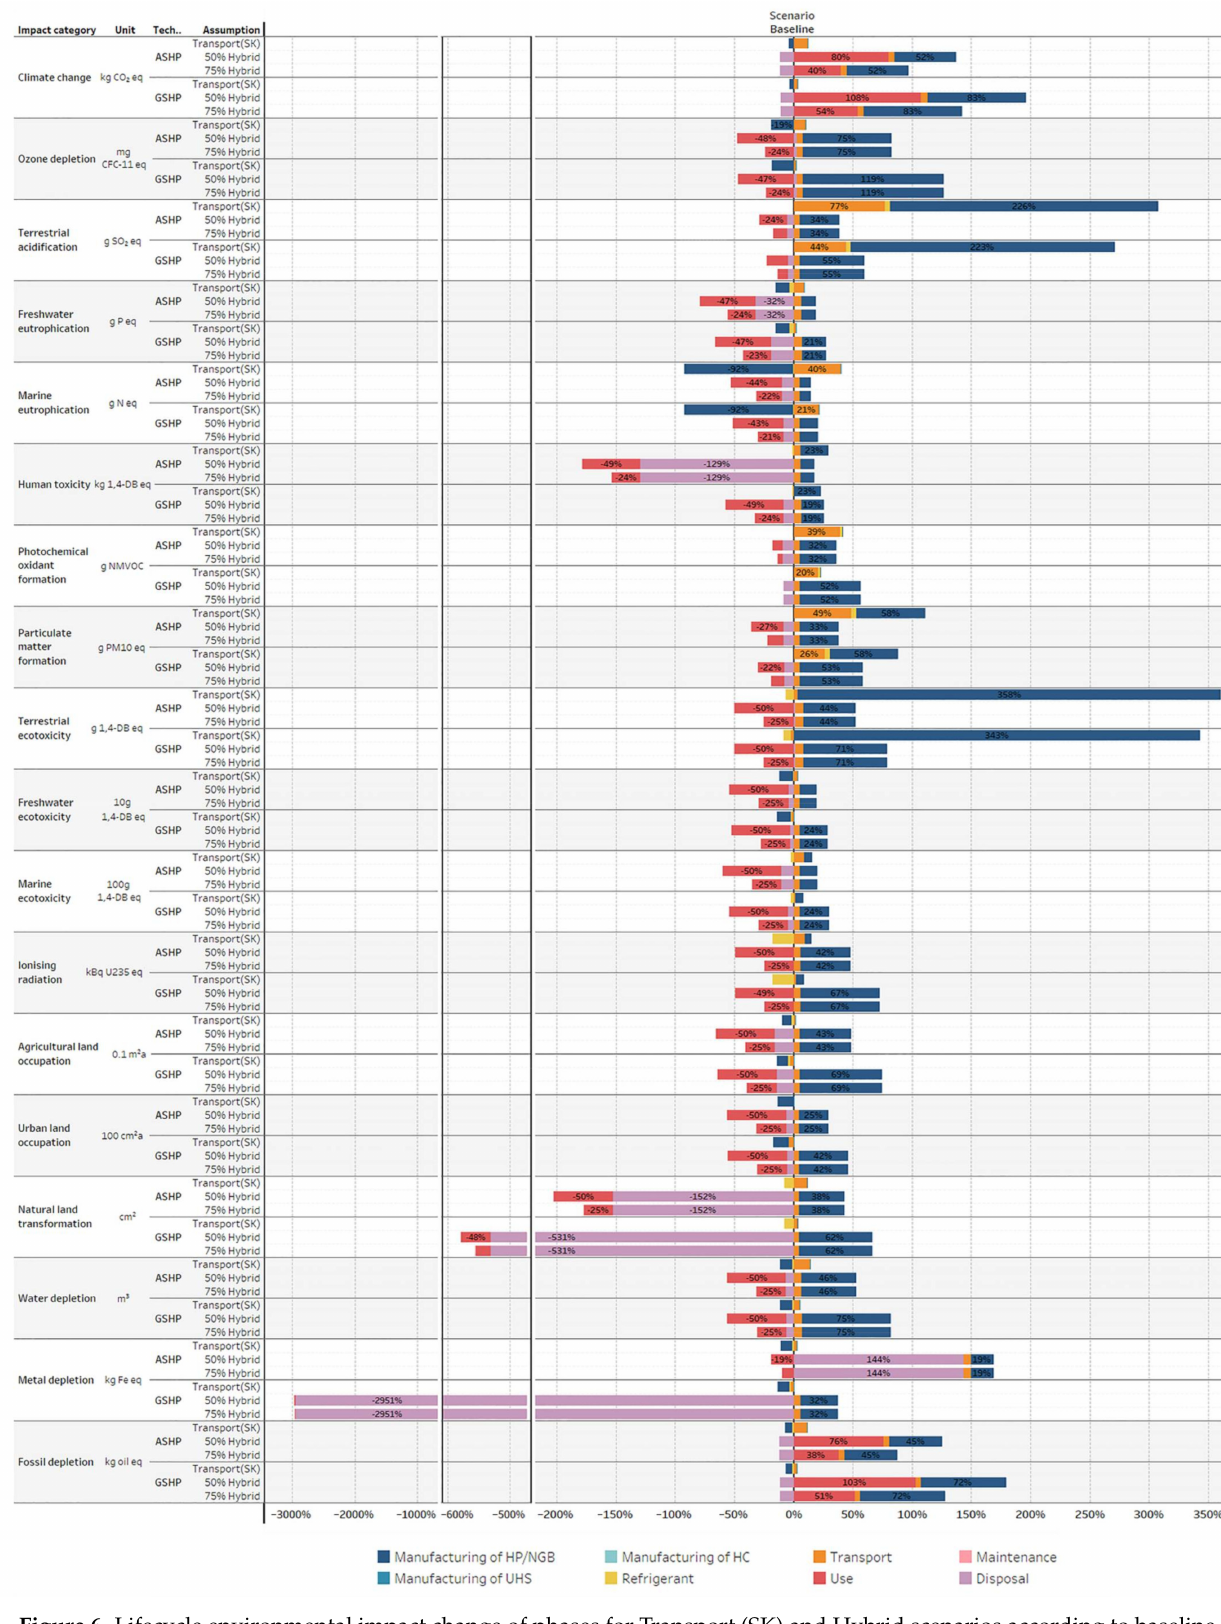
Figure 6. Lifecycle environmental impact change of phases for Transport (SK) and Hybrid scenarios according to